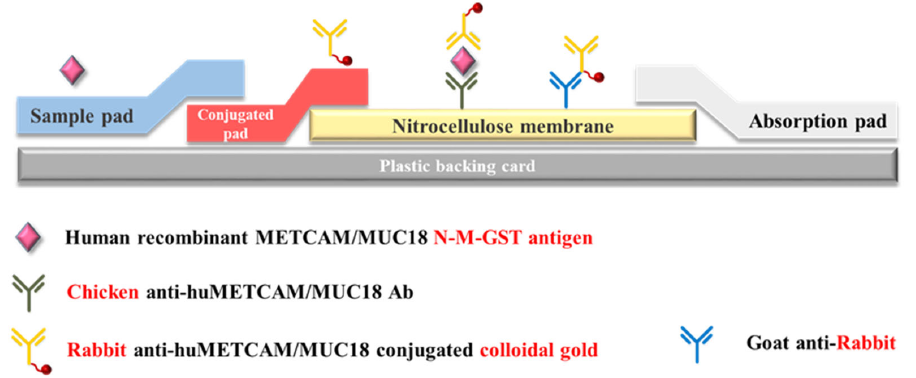
Figure 2. The procedure of the traditional LFIA [41].